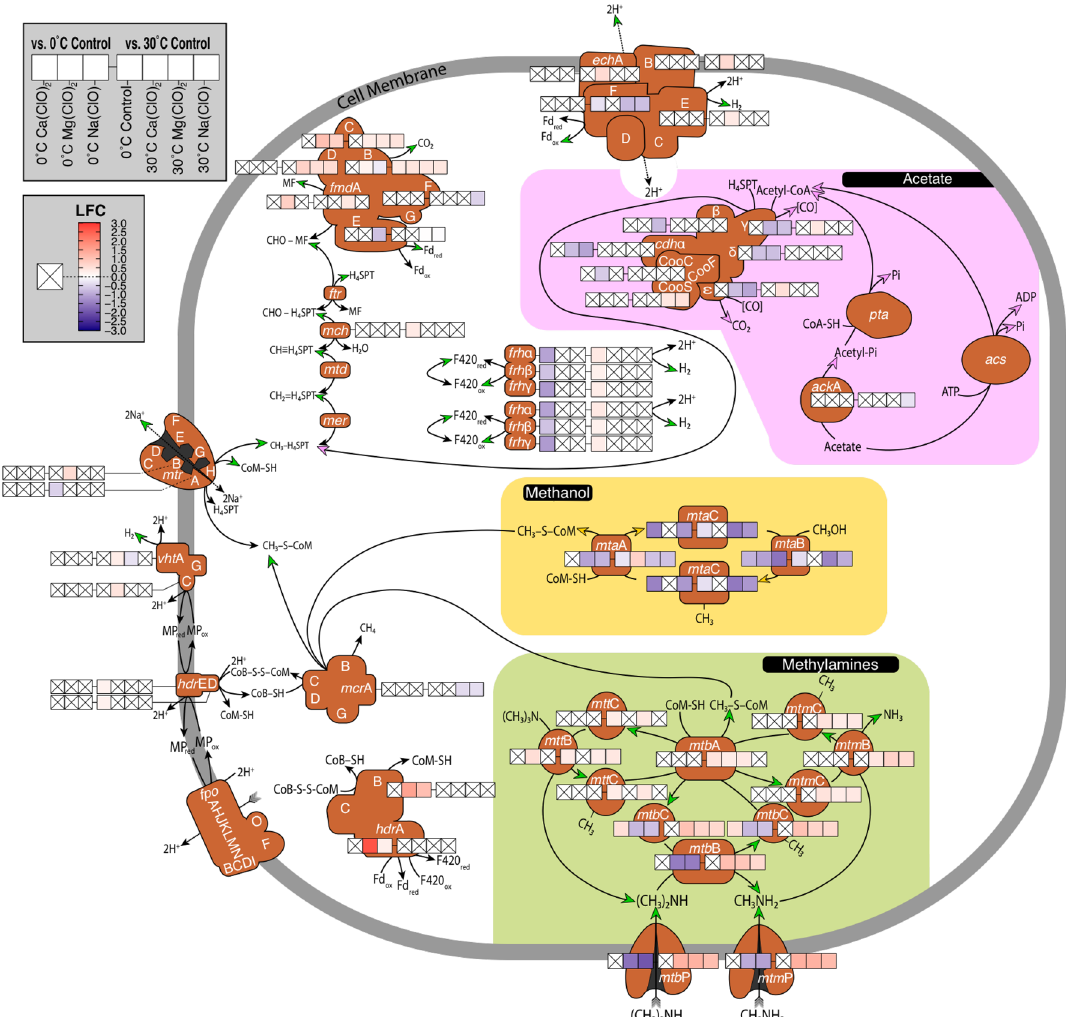
Figure 3. Statistically significant differential expression (Log 2 -fold change, LFC; Wald test, P < 0.05) of methanogenesis genes in M. barkeri strain MS. Differential expression of each gene across 7 assessed conditions is indicated via heatmap. Averages are presented for multi-copy genes (for exact values, reference Tables 1 and 2). Differential expression of genes in 0 °C perchlorate-amended transcriptomes are relative to the expression patterns of the 0 °C perchlorate-free control. Perchlorate-amended 30 °C and 0 °C perchlorate-free control transcriptomes are relative to the expression patterns of the 30 °C perchlorate-free control. Crossed white boxes indicate no statistically significant difference in expression. Heatmaps are excluded from genes exhibiting no significant differential expression across all conditions. Genes involved in non-hydrogenotrophic (H 2 /CO 2 ) pathways are encompassed in colored boxes with pathway directionality indicated by matching arrowheads (green: methylamines; pink: acetate; yellow: methanol). Full names of listed genes and metabolites are found in Tables S13 and S14,